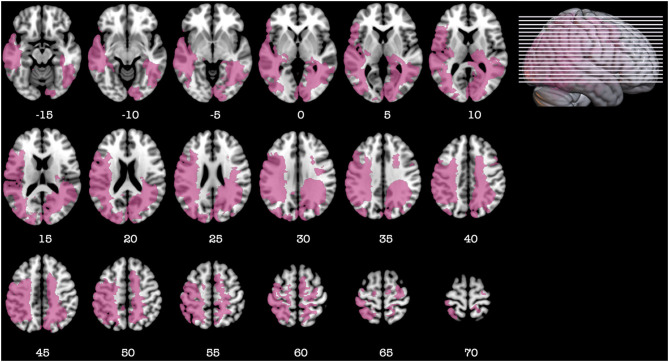
Representative axial slices depicting the anatomical overlap between the participants used in the Koenigs et al. study and in the current study who were members of the cerebellar group with large cortical lesions. Anatomical overlap is represented in pink. Z-values shown at the bottom of each slice indicate the z coordinates (MNI) of each axial slice represented in the 3D view of the brain by white line. Images are in radiological space (i.e., right is left).